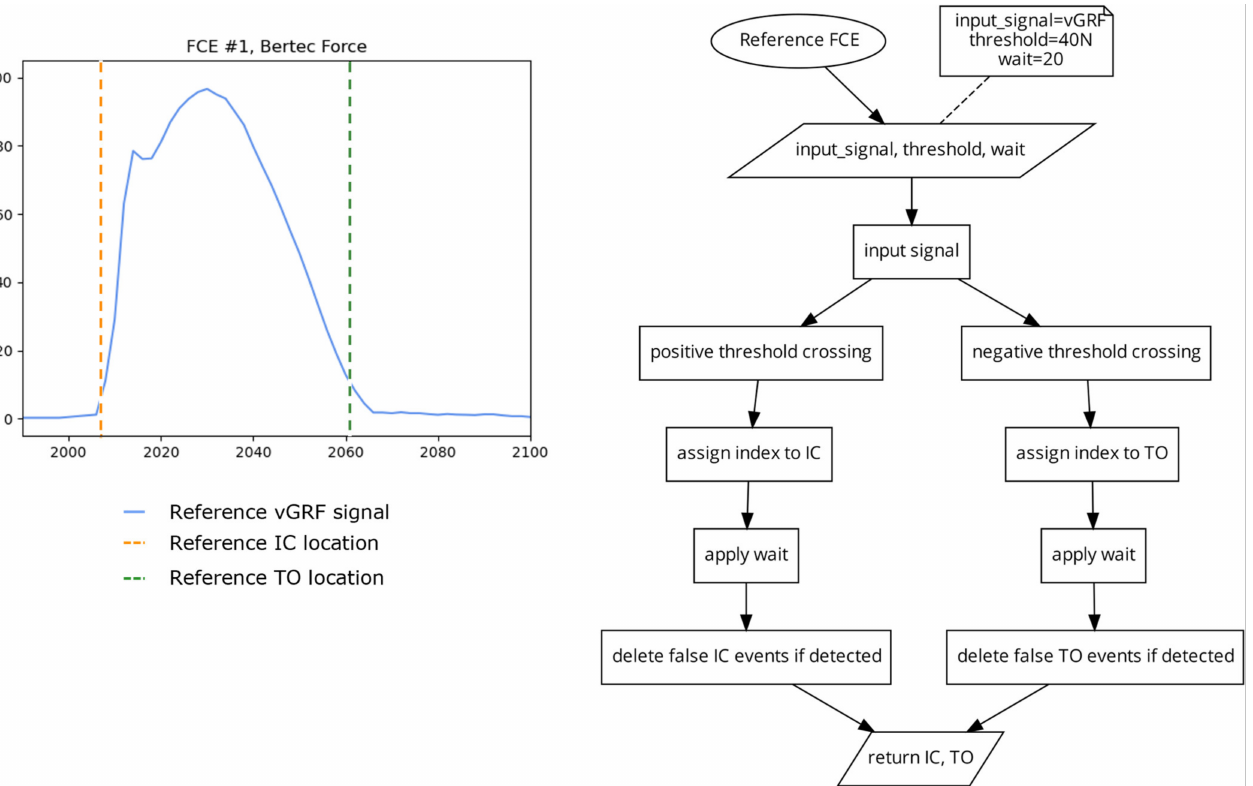
Figure 3. Plot ( left ) displaying a single stride and location of the reference IC and TO events (dashed vertical), as determined by a standard threshold crossing algorithm ( right ) using a 40 N threshold on the vGRF